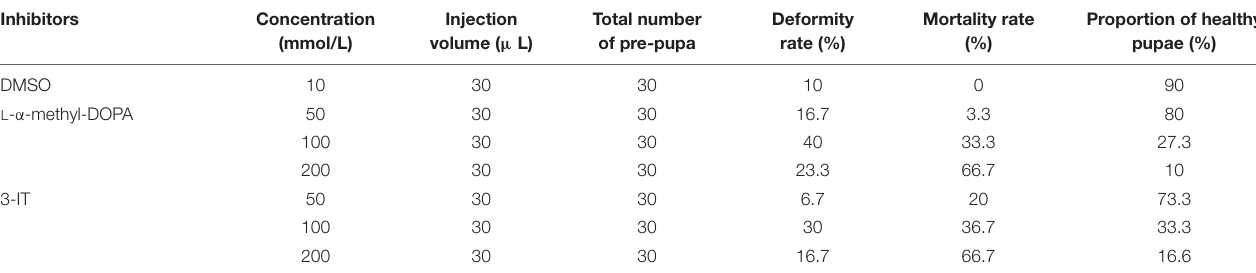
Injection Total number Deformity Mortality rate Proportion of healthy (mmol/L) volume ( µ L) of pre-pupa rate (%) (%) pupae